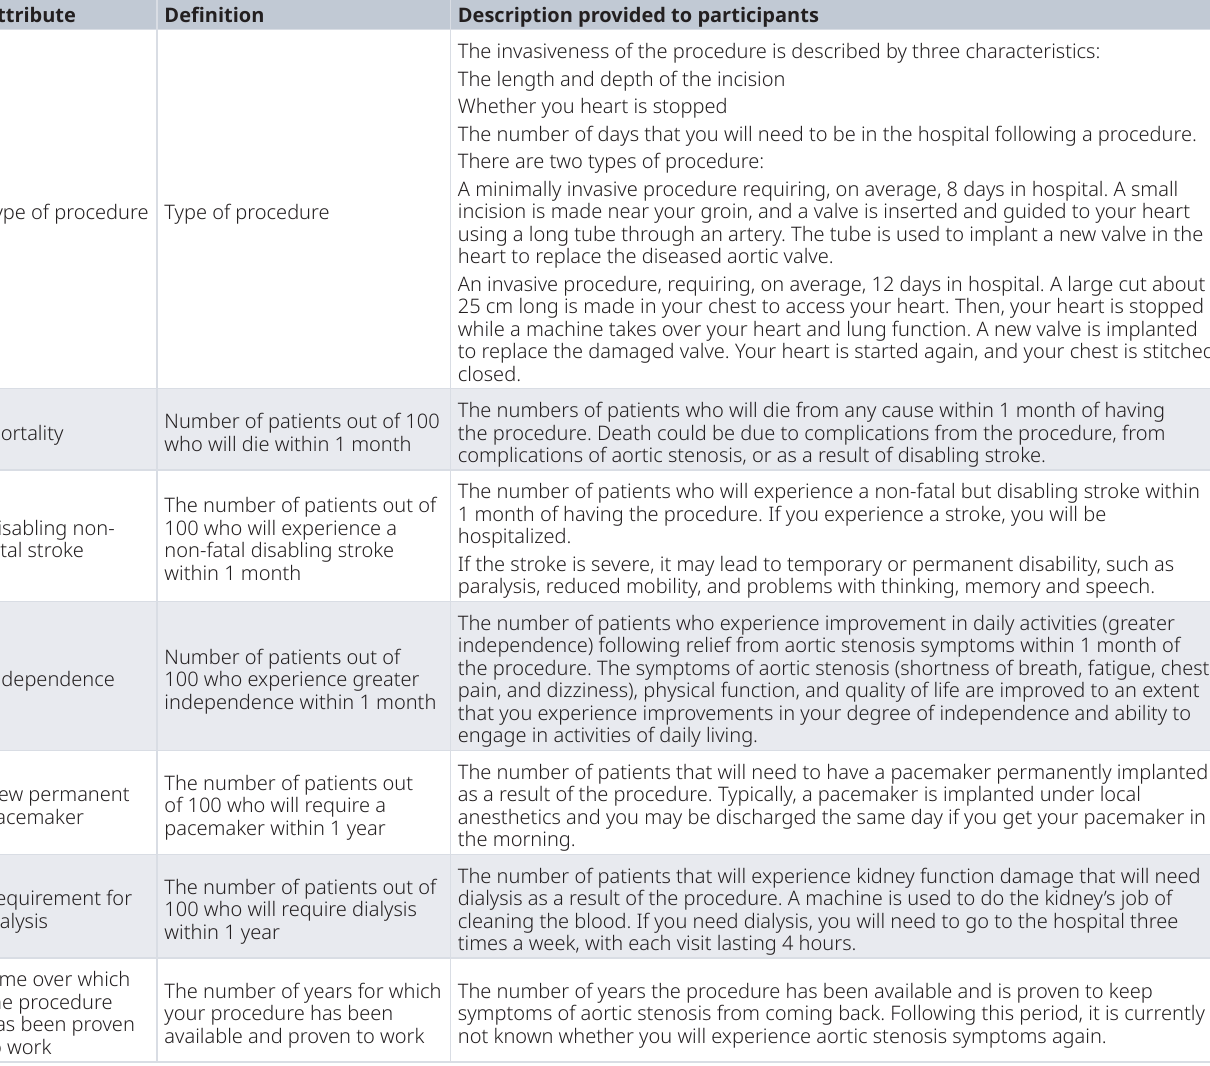
Table 1. Selected attributes for the patient-centered benefit-risk analysis of transcatheter aortic valve replacement vs surgical aortic valve replacement.